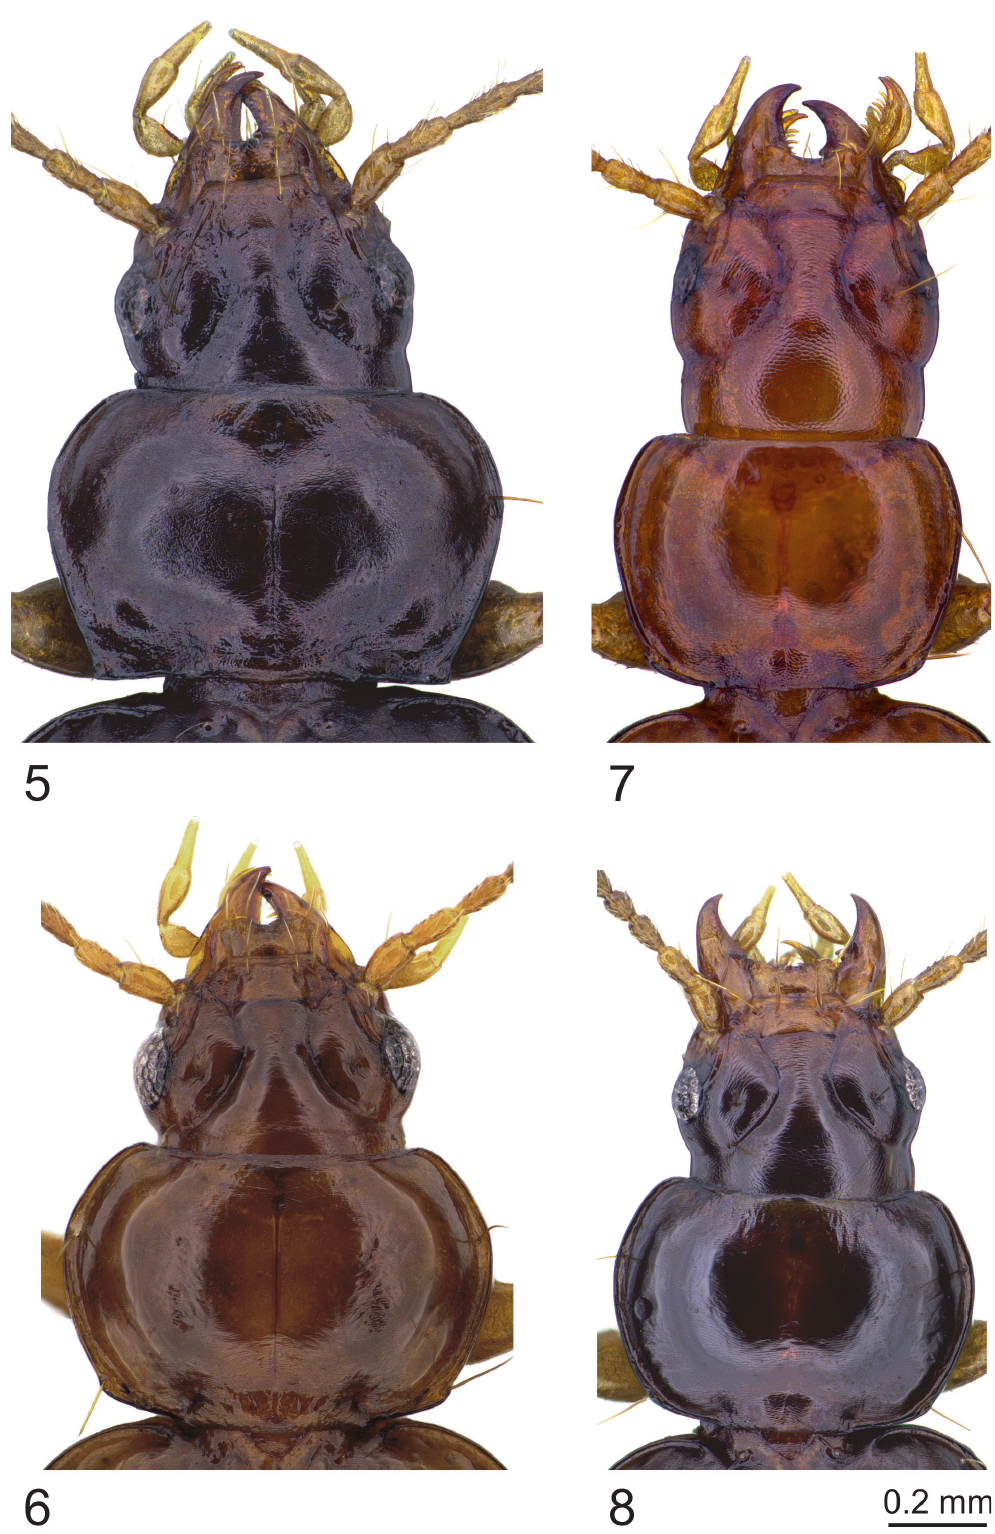
Figs 5–8. Trechus spp., head, pronotum. 5 . T. mattisi sp. nov., paratype, ♂. 6 . T. transversicollis sp. nov., holotype. 7 . T. minitrechus sp. nov., paratype, ♂. 8 . T. nanulus sp. nov., paratype,